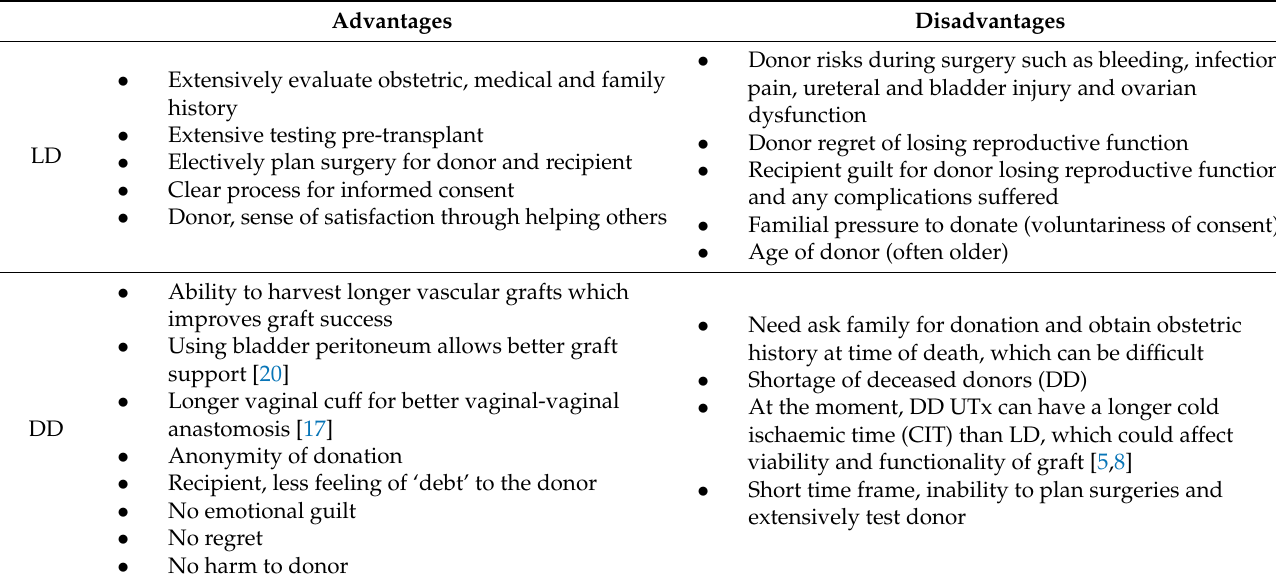
Table 1. Advantages and disadvantages of living donor (LD) and deceased donor (DD) uterus